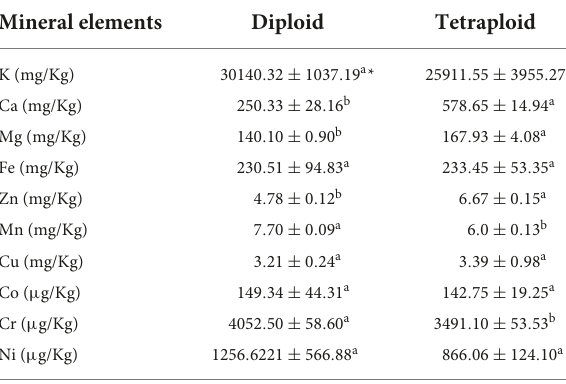
TABLE 3 Mineral elements detected in diploid and tetraploid Anoectochilus roxburghii. Mineral